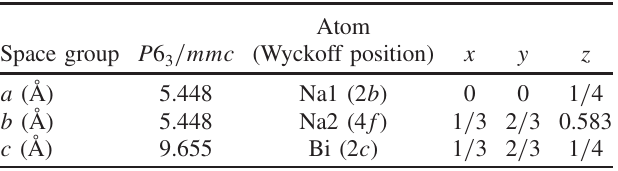
TABLE IV. Lattice constants and atomic parameters of Na 3 Bi. Space group P 6 3 =mmc